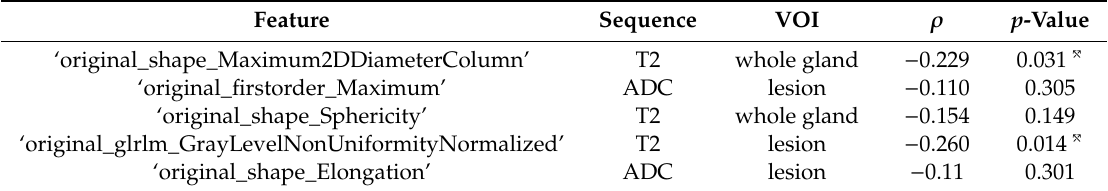
Table 5. Spearman correlation coe ffi cient ( (cid:37) ) for correlation of the ISUP grade with the first five radiomic features chosen by mRMR for csPCa vs. cisPCa prediction. Table 2. Results of ROC analysis for the two selected classification tasks. Predictor malignant vs. benign lesions